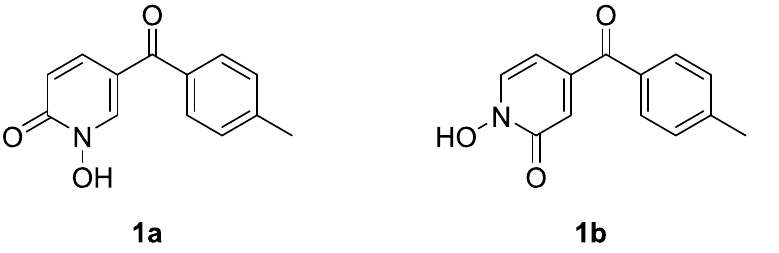
Figure 2. Target compounds 1a and 1b .